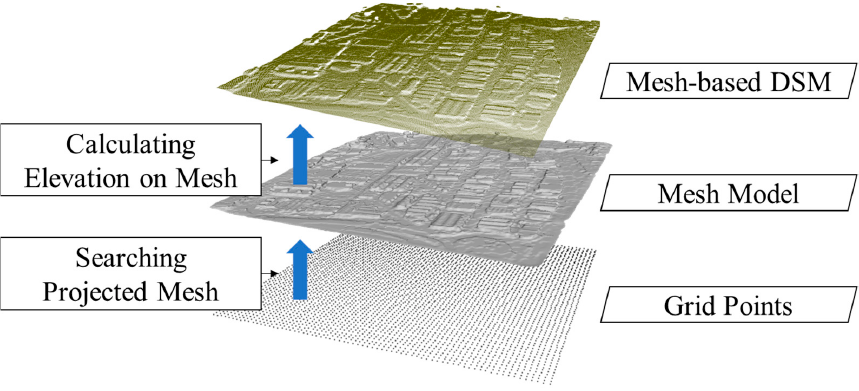
Figure 6. Process of extracting the elevation of grid points from a mesh model.